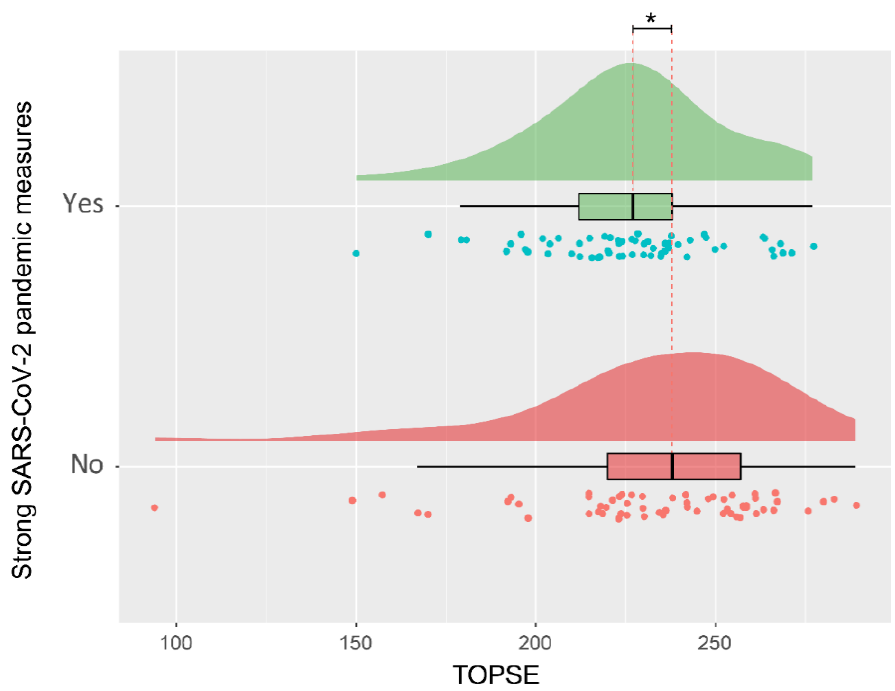
Figure 3. Visualization of the distribution of parental self-efficacy during the lock-down period or before and after. * Significant difference p <